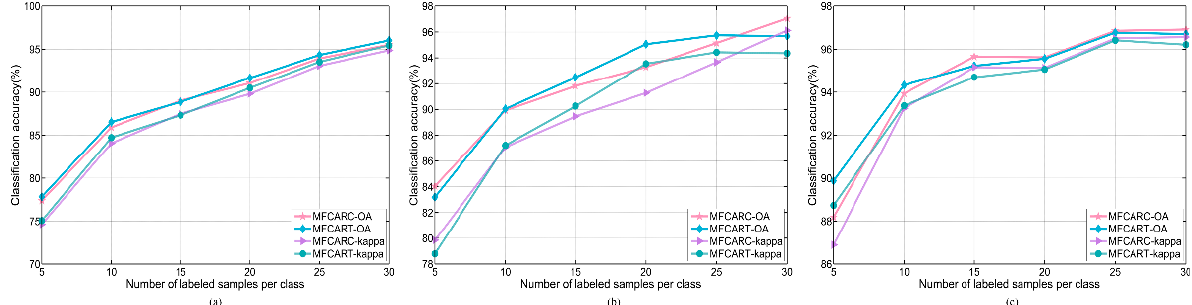
Figure 14. Classification accuracy versus the number of training samples per class. ( a ) Indian Pines. ( b ) Pavia University. ( c ) Salinas.